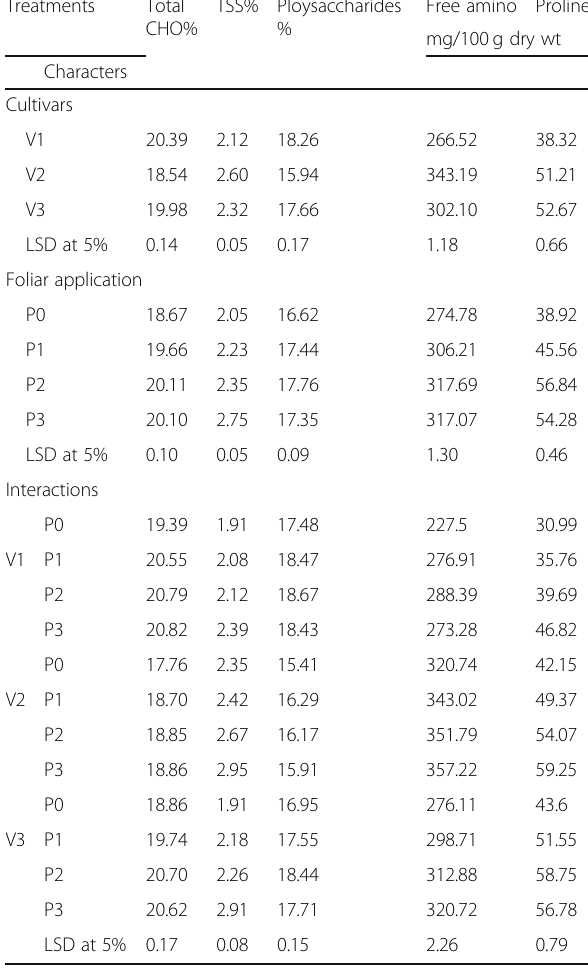
Table 5 Effect of cultivars, foliar application of garlic extract, ascorbic acid or nicotinamide and interactions on carbohydrate constituents, free amino acids and proline contents of faba bean